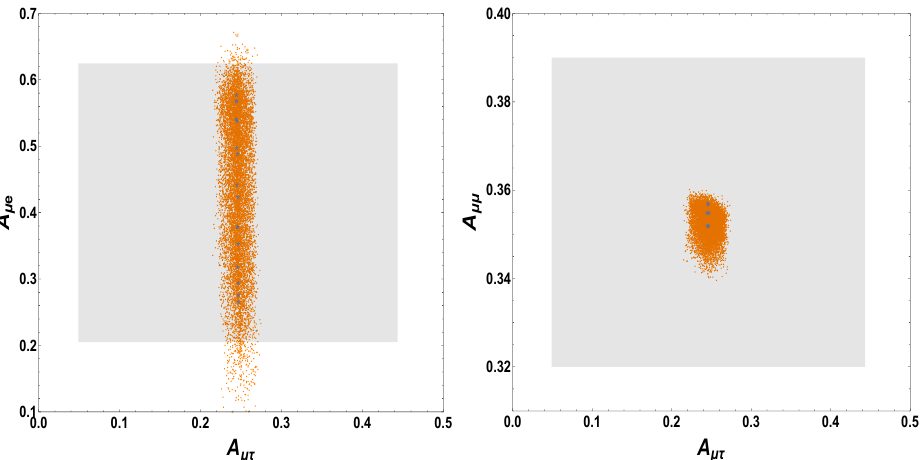
Figure 7. Integrated asymmetries in the ( A µτ , A µ e ) ( left plot) and ( A µτ , A µµ ) planes ( right plot). Blue stars represent the asymmetries in the SM case; the orange dots are the values obtained in the presence of NSI. The grey rectangle shows the 1 σ error range on the standard asymmetries. For sake of simplicity, we do not report the error bars on the orange dots here. Standard neutrino flux has been employed to compute the number of